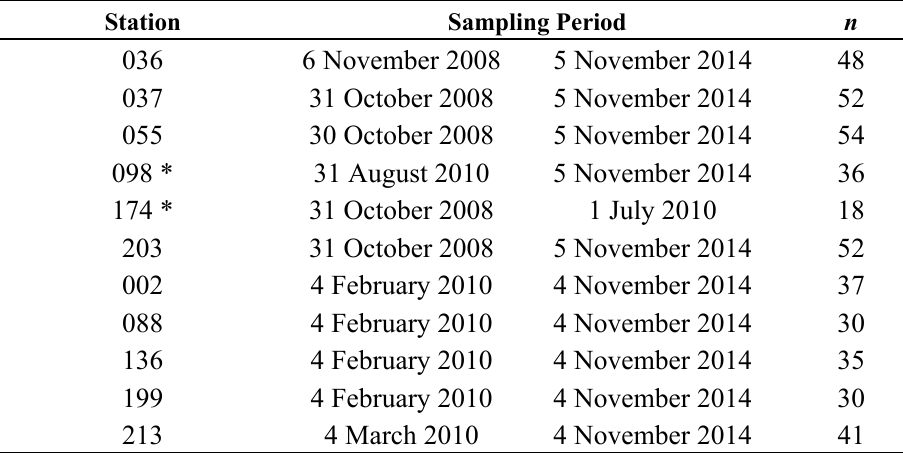
Table 1. Rainfall sampling stations’ designation and sampling period. n = number of samples.